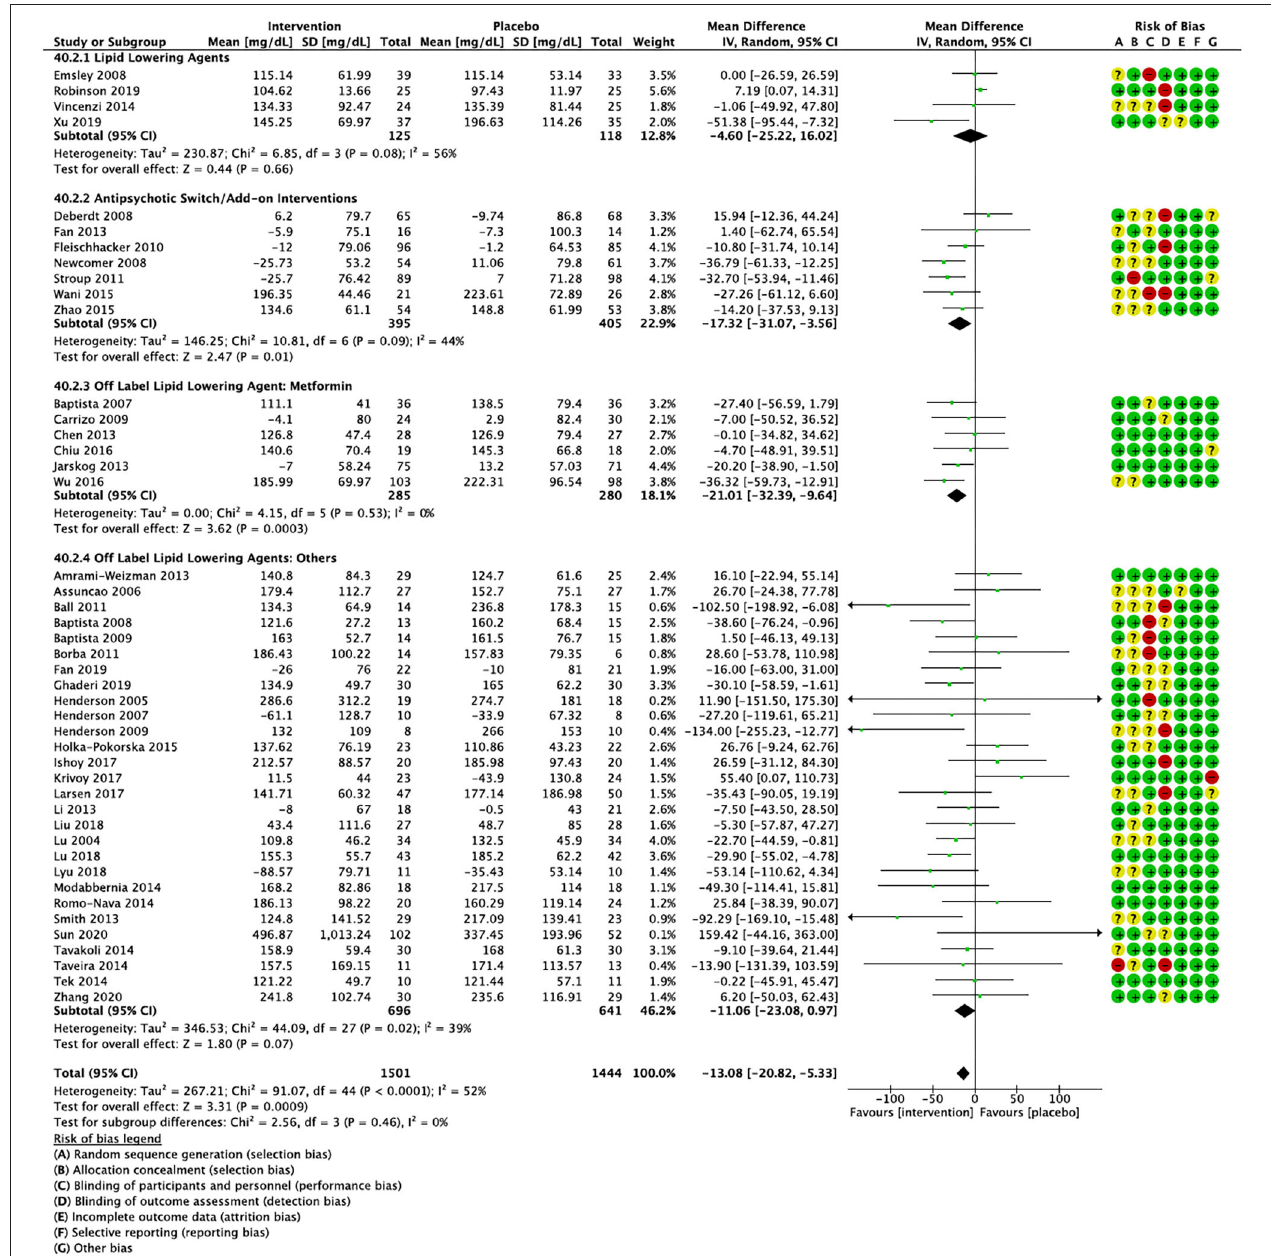
FIGURE 2 | Forest plot showing the pooled mean difference in changes in triglycerides (mg/dL) for all interventions as compared to placebo along with subgroup analyses and Risk of Bias assessments.